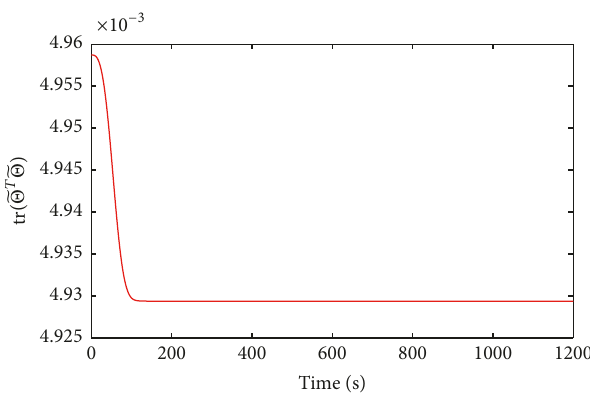
Figure 7: Norm of estimation errors.